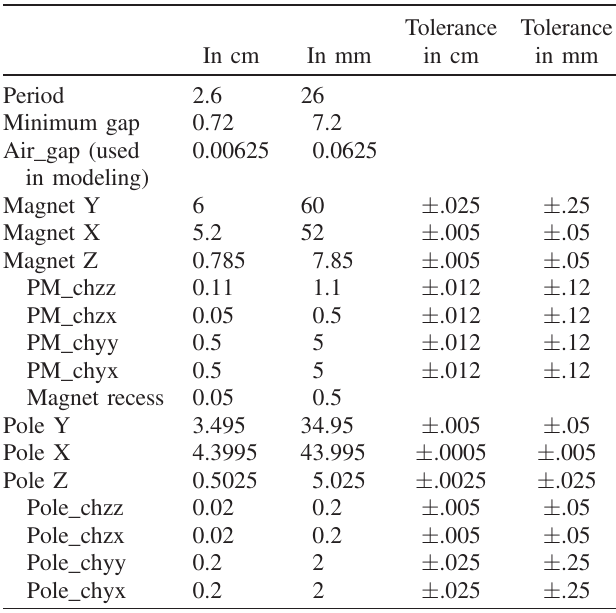
TABLE II. Design parameters for the 2.6-cm-period undulator. Notation on the chamfers: PM_chzx, PM_chzz are the x and z dimensions of the z chamfer. (Note that x is horizontal and y is vertical on the component dimensions when the undulator is in its horizontal-gap configuration.)